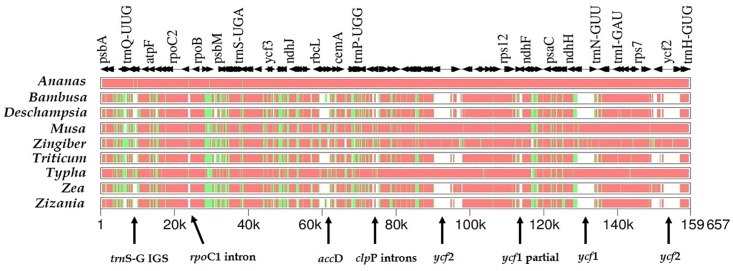
Multipip analysis showing overall sequence similarity of plastid genomes based on complete genome alignment.Levels of sequence similarity are indicated by red (75–100%), green (50–75%) and white (<50%). Comparison was made for ten plastid genomes using Tillandsia usneoides as the reference genome. Arrows indicate gene/intron losses and deletions; partial duplication of the ycf1 is due to IR expansion.